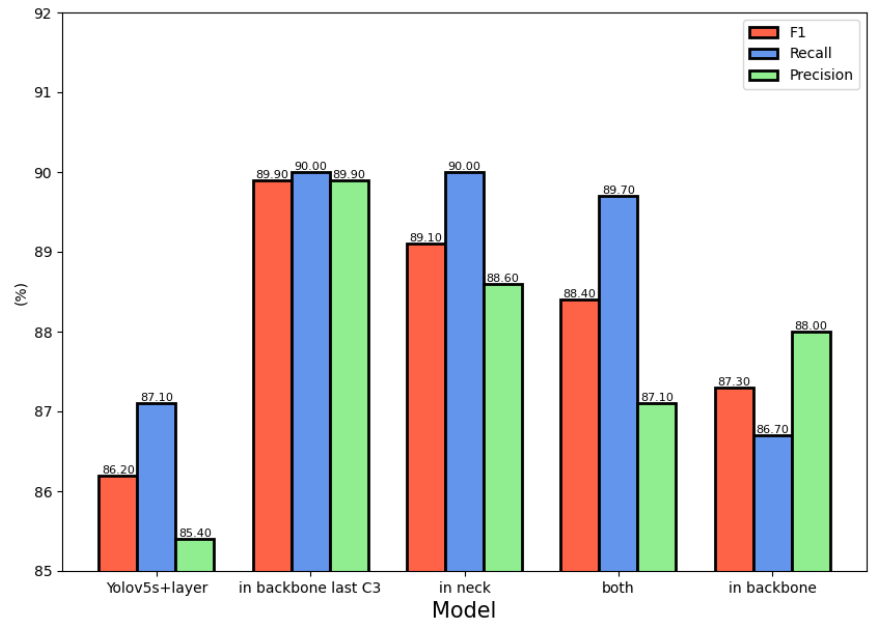
Figure 9. Impact of adding the CBAM in different locations on the model performance indices. Table 2. Comparison results of model performance using different improvement